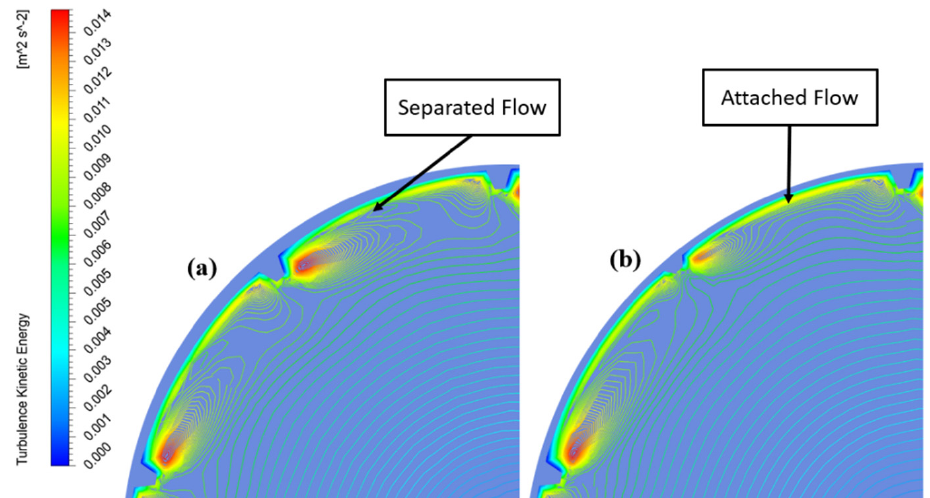
Figure 8. Turbulence kinetic energy contours at Re 12,000 for ( a ) Equal fin height; ( b ) Alternating fin height.